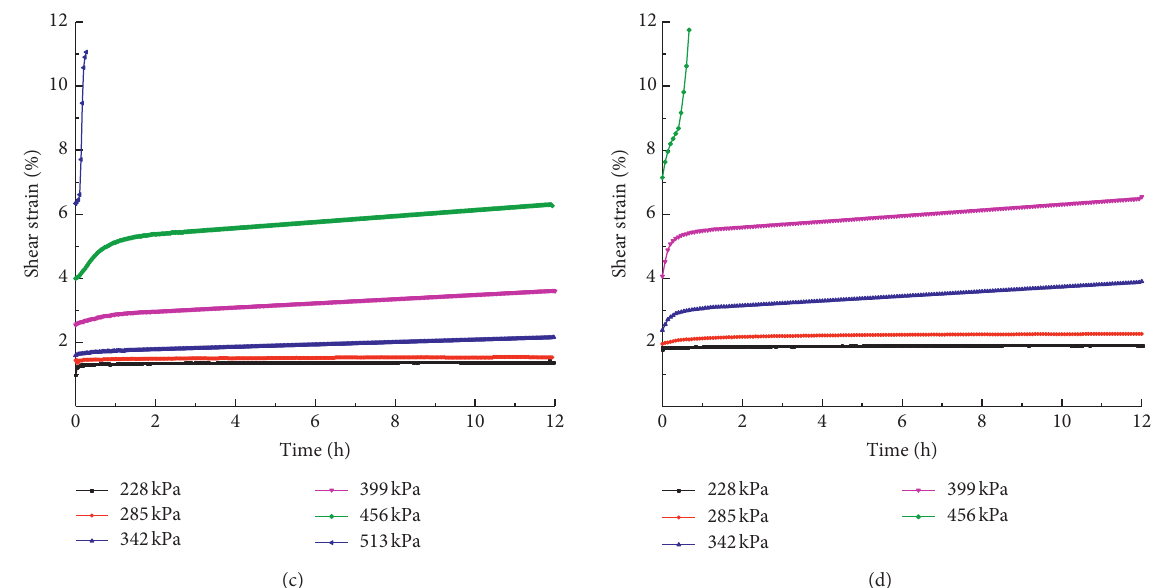
Figure 3: Strain-time curves of soil with various fiber contents. (a) Sample A (unreinforced); (b) Sample B1 (fiber content 0.2%); (c) Sample B2 (0.6%); and (d) Sample B3